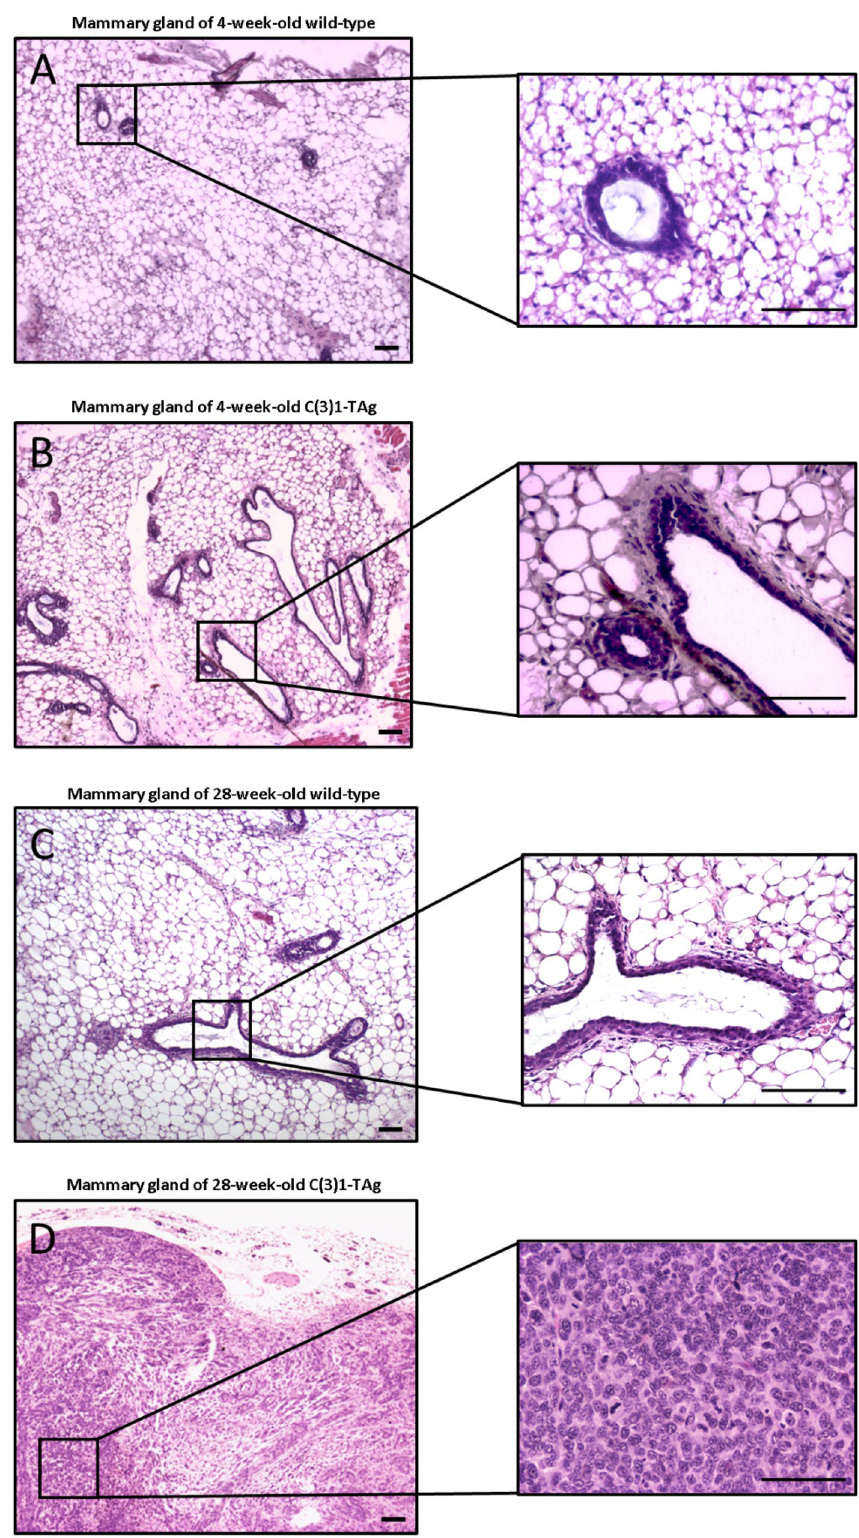
Figure 1. Characterization of carcinoma development in C(3)1-TAg and wild-type mice. ( A ) Mammary tissue from 4-week-old wild-type and ( B ) 4-week-old C(3)1-TAg mice ( C ) Mammary tissue from 28-week-old wild-type and ( D ) 28-week-old C(3)1-TAg. Low and high power magnifications are shown. Tissue from one representative animal of each group is shown. Scale bar: 50